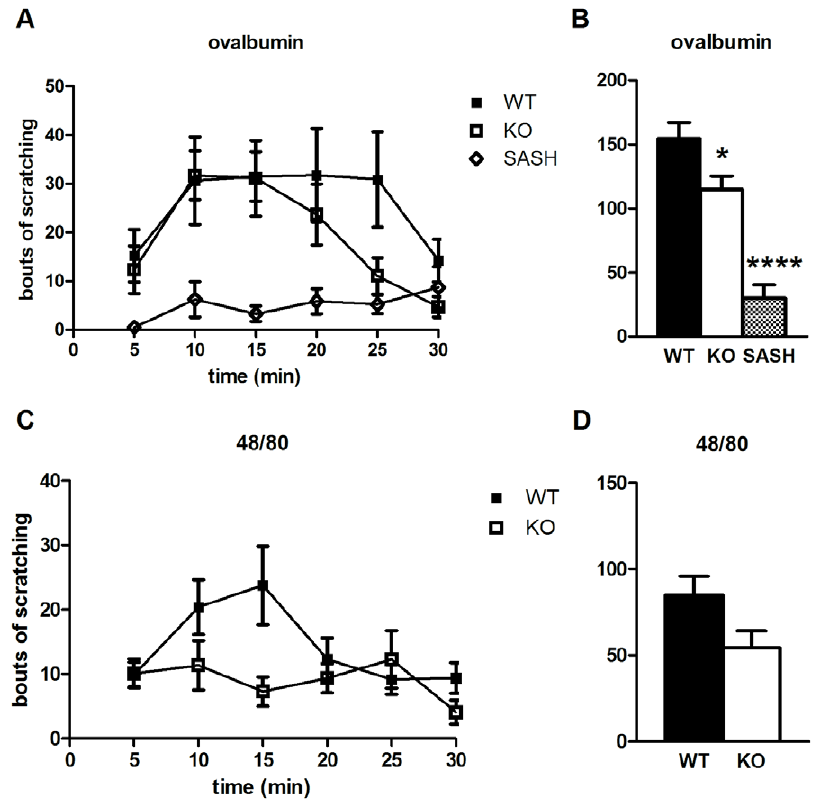
Figure 4. Pirt plays a role in mast cell-dependent itch. ( A , B ) In an allergy model, ovalbumin (50 m g) induces less scratching in Pirt 2 / 2 (n=11) and SASH (n=7) mice compared to WT controls (n=8). ( C , D ) Pirt KO mice (n=11) show a trend toward decreased scratching compared to WT (n=13) when injected with compound 48/80 (30 m g), but this difference just misses statistical significance ( p , 0.06). * p , 0.05, **** p , 0.00001; two- tailed unpaired t